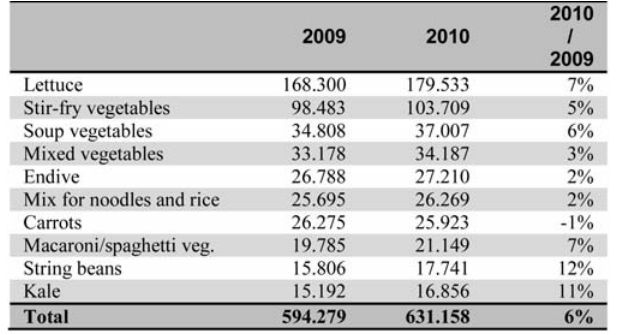
Source: PT / Nielsen